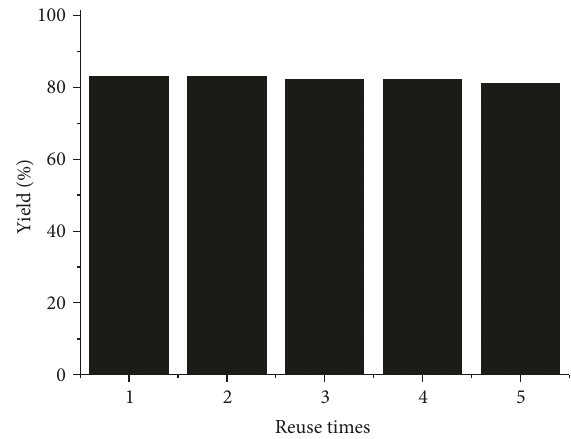
Figure 2: Reusability of ionic liquid